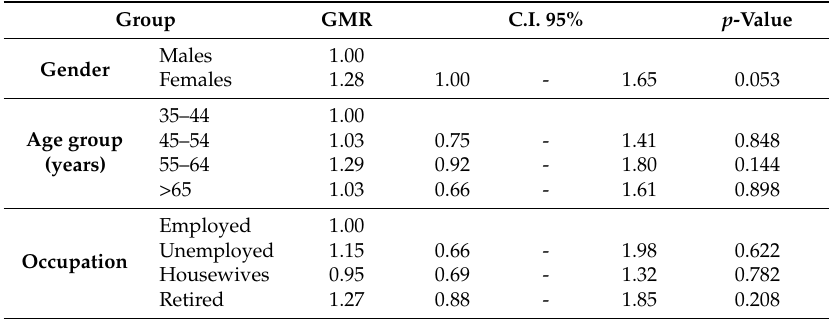
Table 3. Association between urinary concentration of SPMA and gender, age, and occupation. GMR = geometric mean